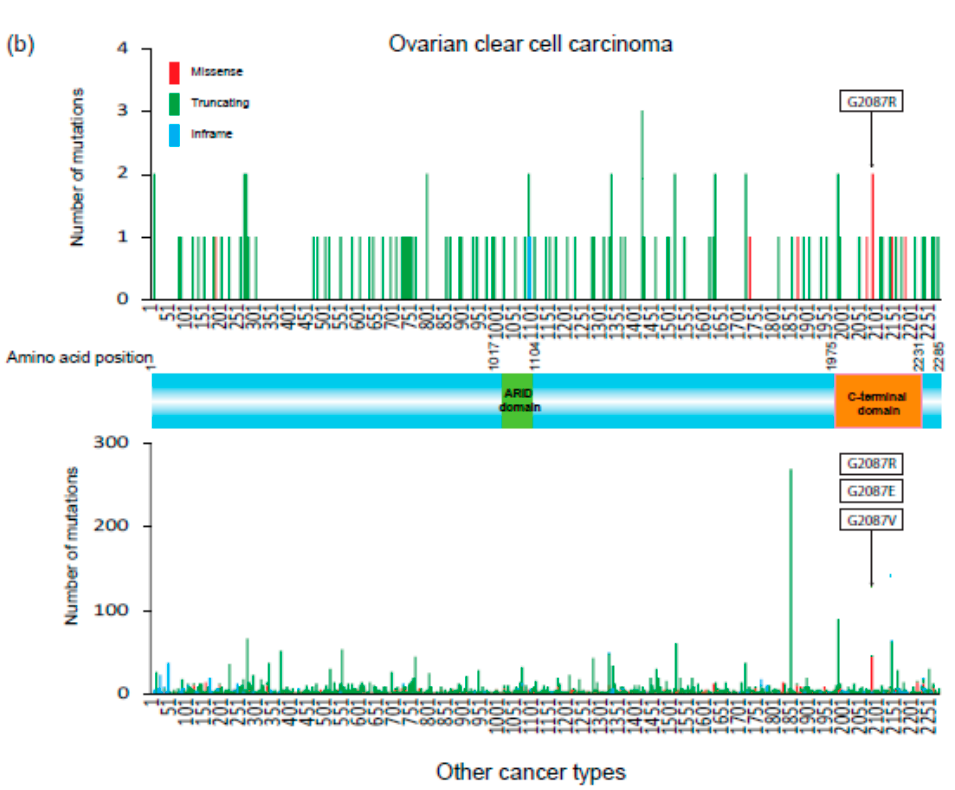
Figure 3. ARID1A alterations in OCCC. ( a ) Frequency of ARID1A mutations and loss of BAF250A/ARID1A protein expression in OCCC in Japan, the US, Canada, and Australia. Frequen- cies in published results [12,13,32–37] are expressed as the mean ± standard error. ( b ) Distribution of ARID1A mutants on the wild-type BAF250A/ARID1A protein sequence (GENIE Cohort v8.1). Upper and lower panels show mutations in OCCC (127 mutations) and other cancers, respectively. Mutations are colored by the type of mutations: missense, truncating (7114 mutations: nonsense, frameshift, and splice site mutations), or in-frame. Deleterious missense mutations at codon 2087 are indicated by boxes.